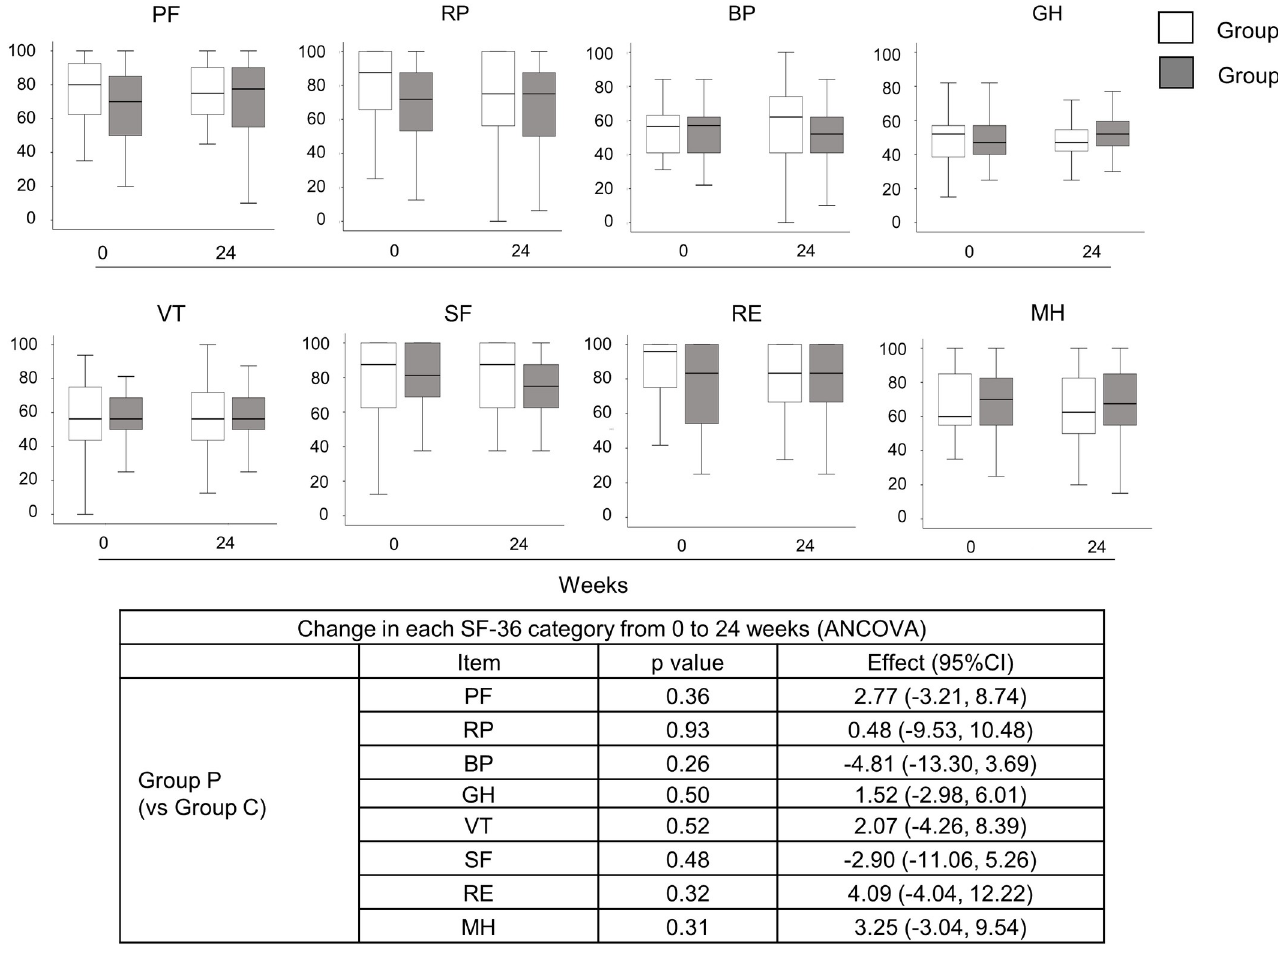
Fig 3. Changes in SF-36 score over the course of the study in the FAS. Data are presented as box-and-whisker plots. White box, Group C; gray box, Group P. ANCOVA; analysis of covariance, BP, bodily pain; C, control; CI, confidence interval; GH, general health; MH, mental health; P, propolis; PF, physical functioning; RE, role emotional; RP, role physical; SF, social functioning; SF-36, 36-item short-form health survey; VT,